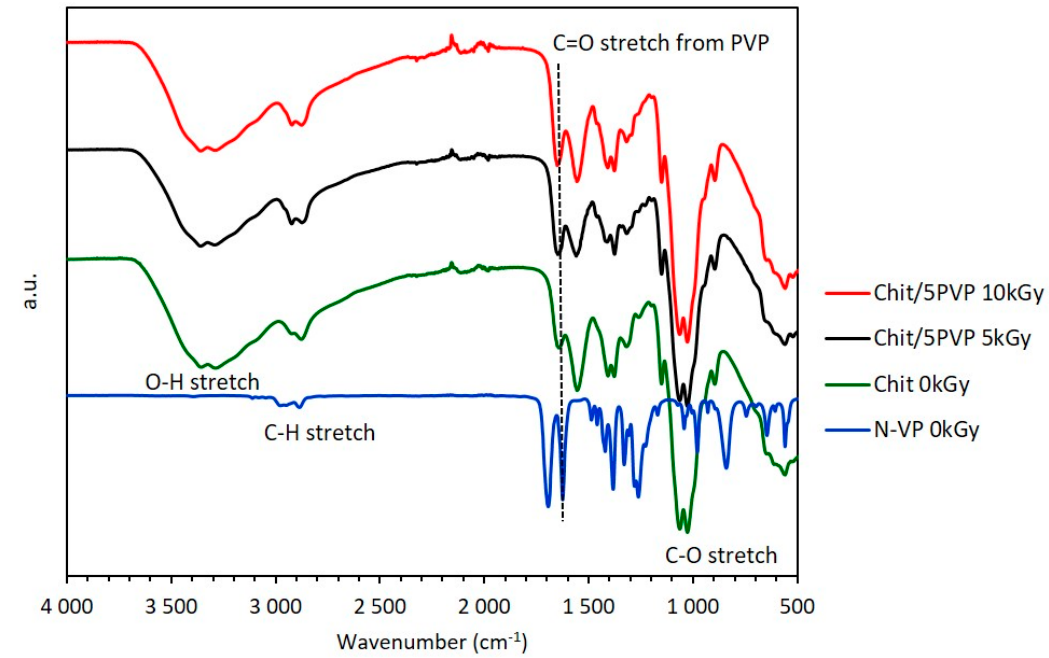
Figure 3. ATR-FTIR spectra of pristine N-vinyl 2-pyrrolidone (N-VP), pristine chitosan and chitosan/PVP (5% PVP; N 2 bubbling) matrices irradiated at different doses.